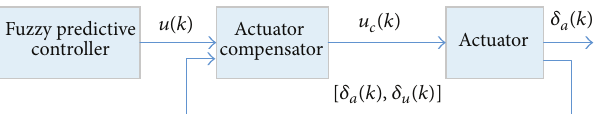
Figure 2: Structure of the actuator compensation